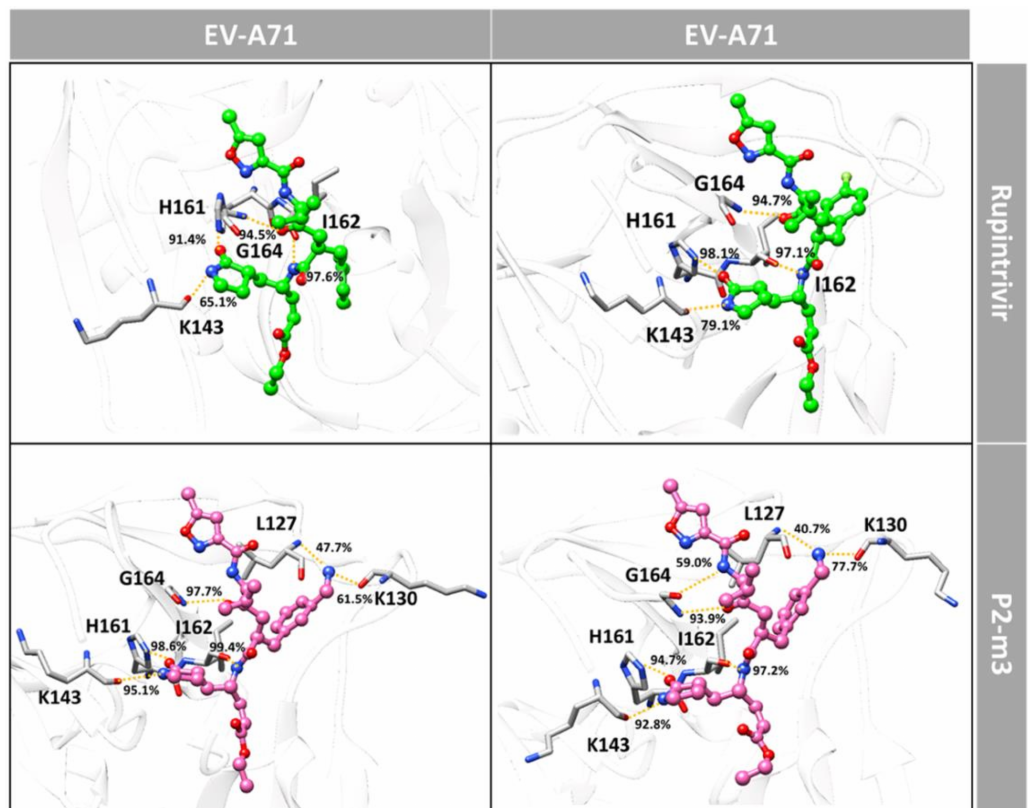
Figure 5. Hydrogen bonding interactions of the rupintrivir and its analog P2-m3 (bond and stick model) with EV-A71 and CV-A16 3Cpro residues (stick model).